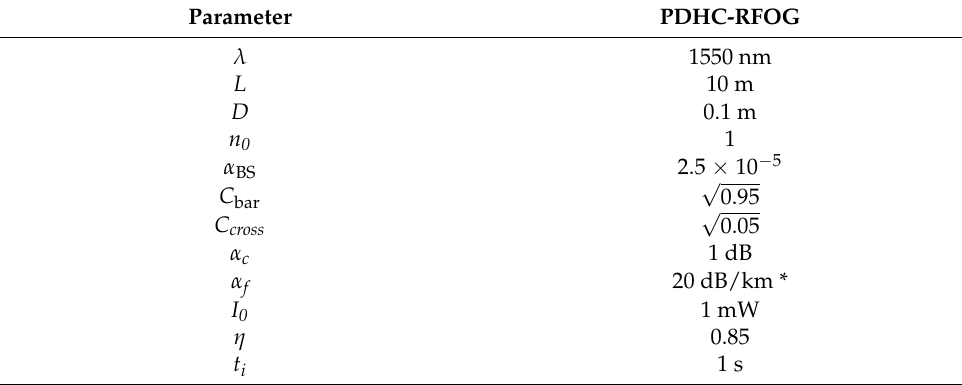
Table 1. Parameters for the